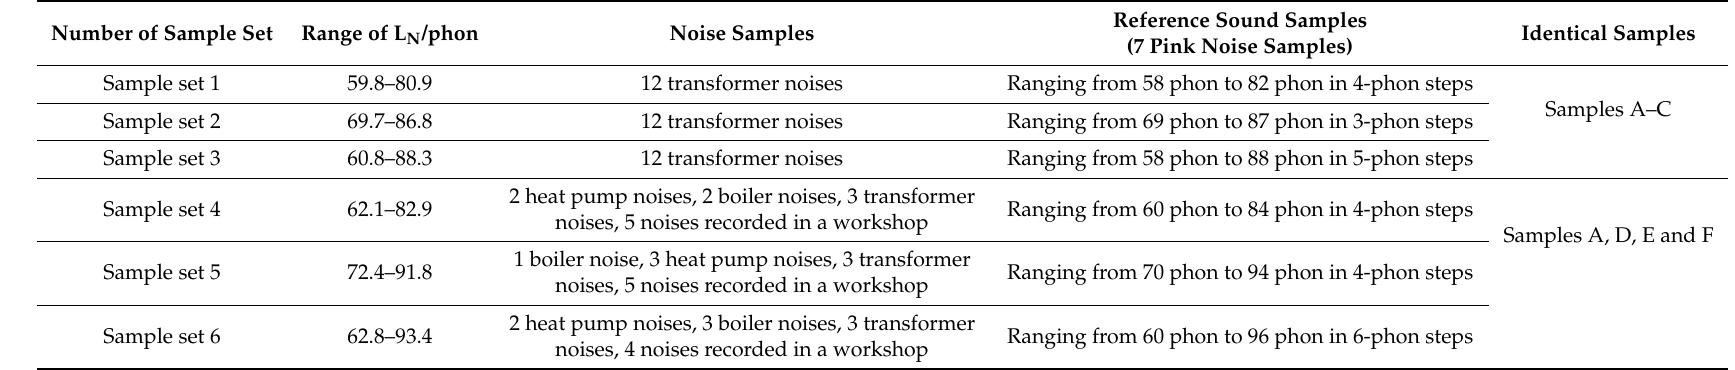
Table 2. The composition of sample sets